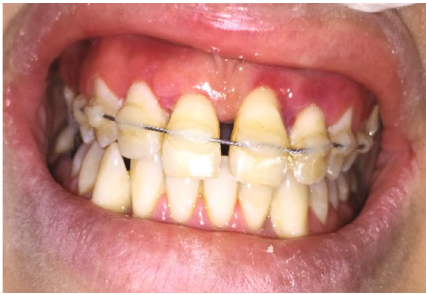
Figure 5: 1-week posttrauma.